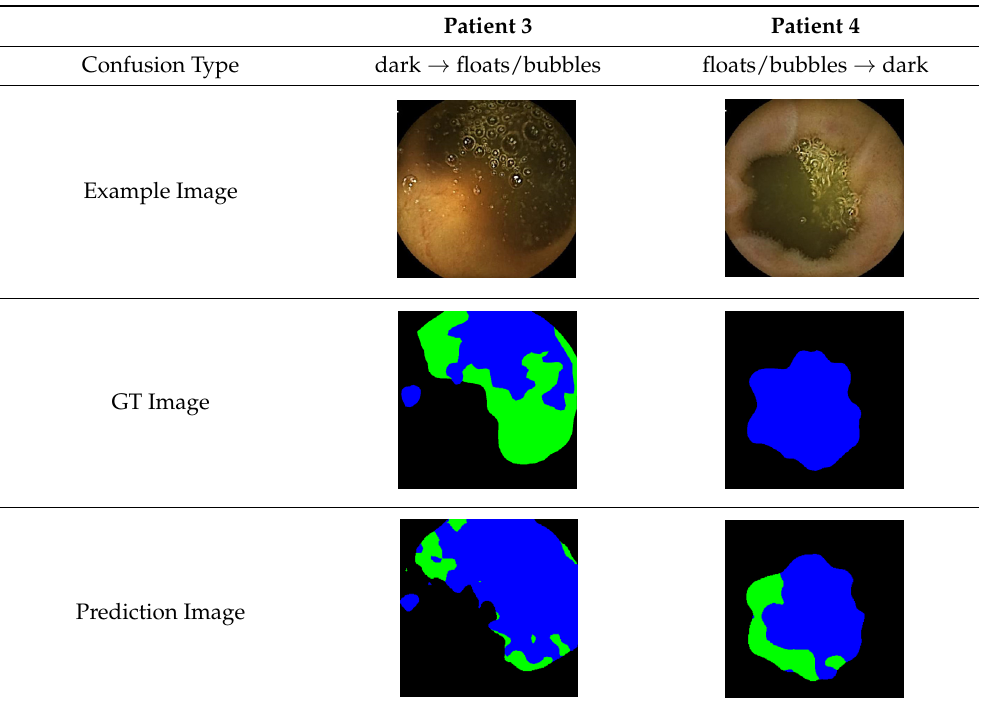
Black, green, and blue colors represent clean, dark, and floats/bubbles regions, respectively. GT: ground truth.